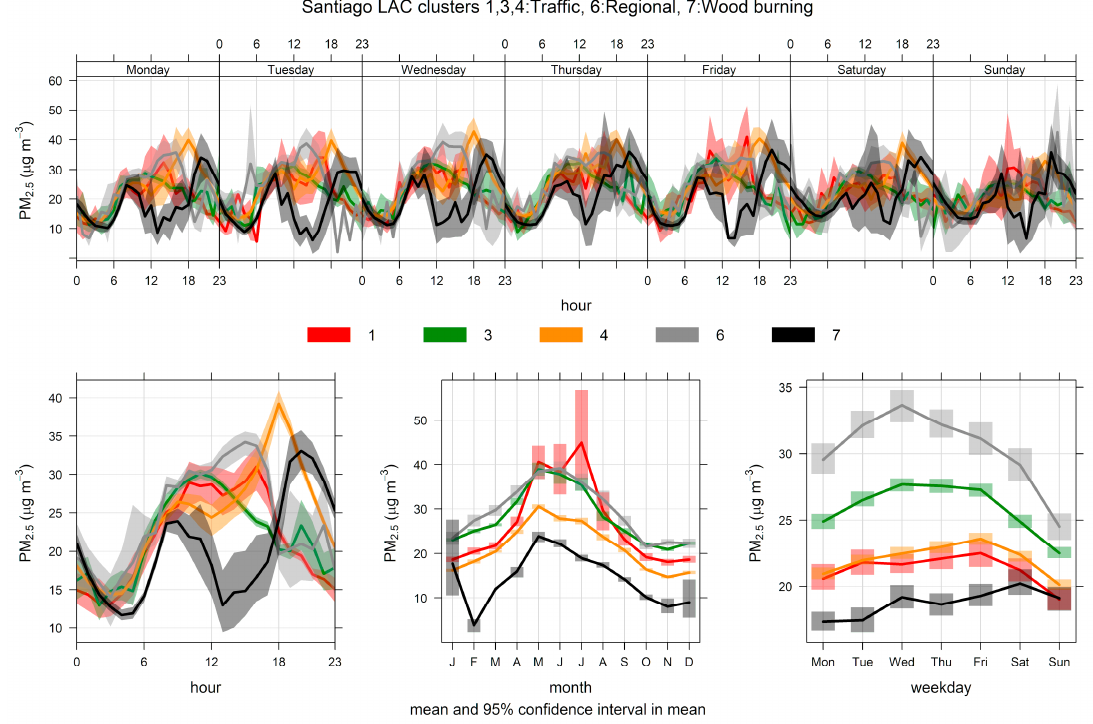
Figure 14. Time variation plot for the cluster analysis source apportionment results for ambient PM 2.5 at Santiago, 2004/01–2012/06, for an eight-cluster solution. For clarity’s sake, only the five major clusters are included.